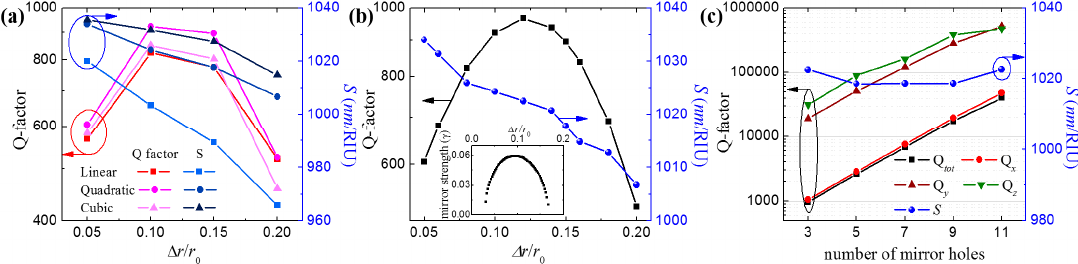
Figure 3. Characteristics of the air gap cavity mode in a PhC NB cavity with a horizontal air gap. ( a ) Q-factor and S as functions of the variation in the size of air holes with different modulation functions to reduce the air holes from the center to the mirror. In the simulation, w = 0.95 a , t = 1.2 a , t g = 0.15 a , and r 0 = 0.45 a . ( b ) Fine optimization of variations in the size of air holes. The inset indicates the mirror strength as a function of variations in the size of air holes. ( c ) Q-factor and S as functions of the number of mirror holes. In the simulation, all other structural parameters are the same as those in (b) except Δ r / r 0 = 0.12.